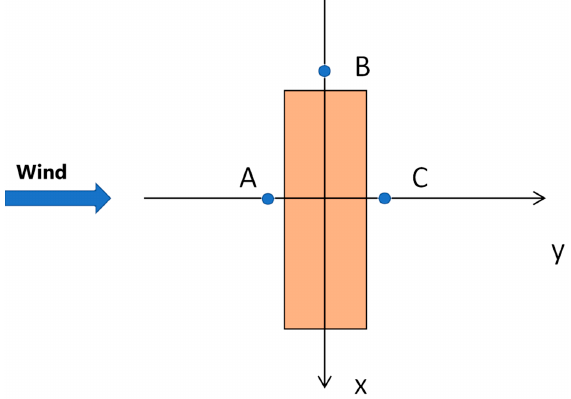
Figure 6. Layout of control points.